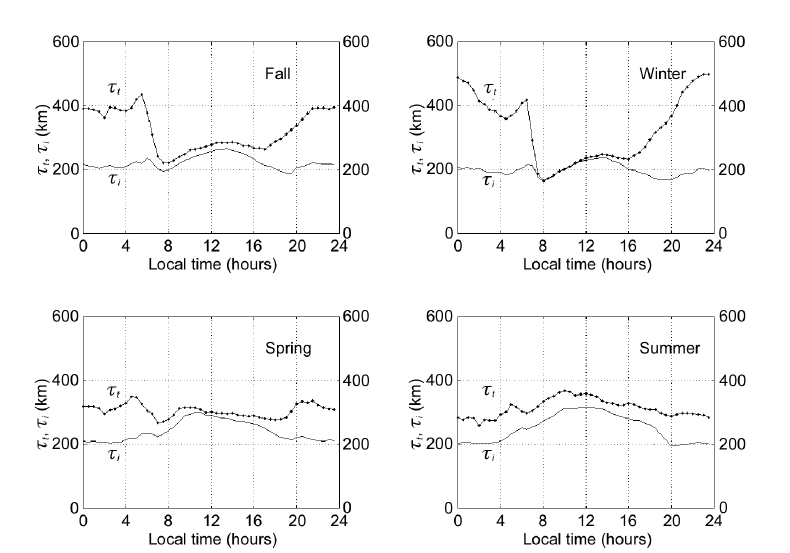
Fig. 8. The daily variation pattern of the slab thickness parameters τ t (black-dotted line) and τ i (black-solid line) at Athens, extracted from the monthly median values, for the four